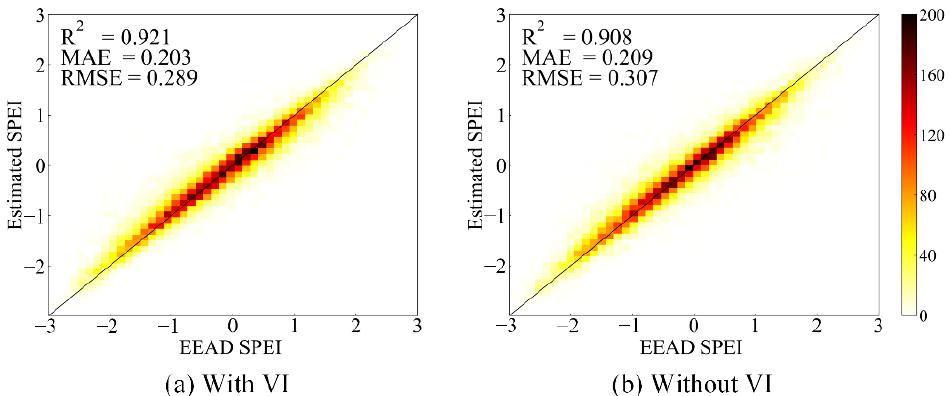
Figure 4. Density scatter plot between EEAD and estimated SPEI from Extra Trees (ET) with ( a ) both gridded climate data and vegetation index (VI) as input, and ( b ) with only gridded climate data as input. Results are from cross-validation.